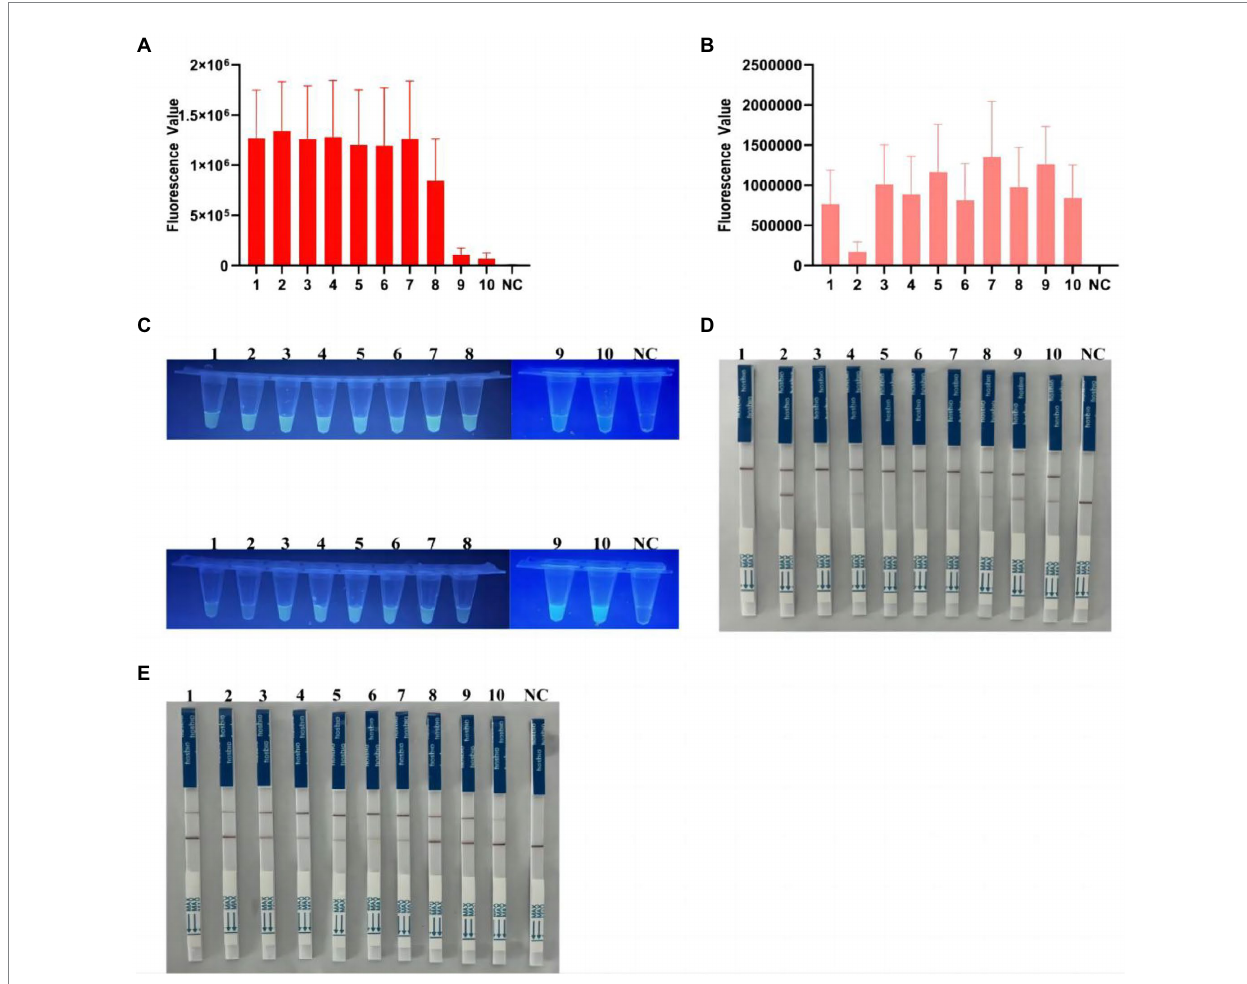
FIGURE 6 Detection of C. difficile dual toxin gene in clinical samples based on CRISPR-Cas12a. (A) Ten clinical samples were amplified by multiplex RPA for Cas12a fluorescence analysis of tcdA gene. (B) Ten clinical samples were amplified by multiplex RPA for Cas12a fluorescence analysis of tcdB gene. (C) End-point fluorescence for tcdA and tcdB in 10 clinical samples. All samples showed visible fluorescence. (D,E) Multiplex RPA-Cas12a-LFS assay was used to detect tcdA and tcdB genes in 10 clinical samples. All sample test lines were visible. NC, negative control. All experiments were repeated at least 3